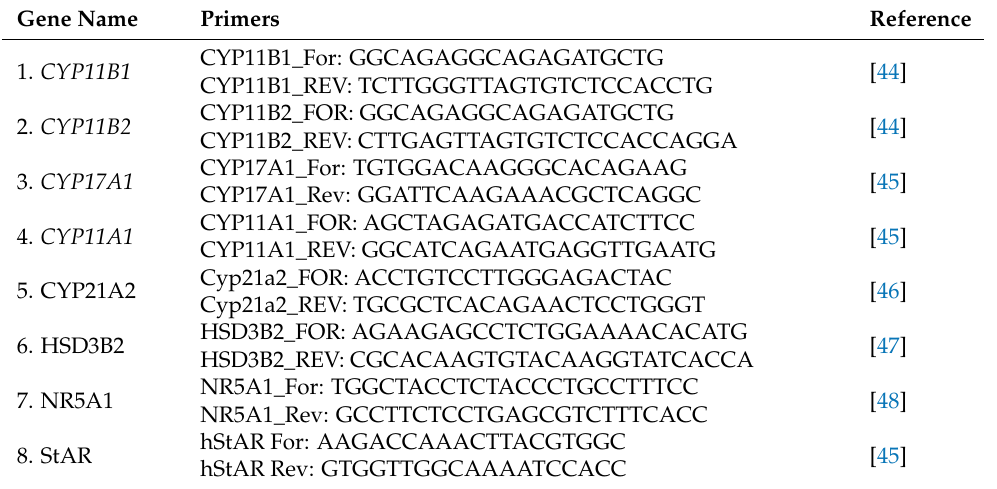
Table 3. qRT-PCR